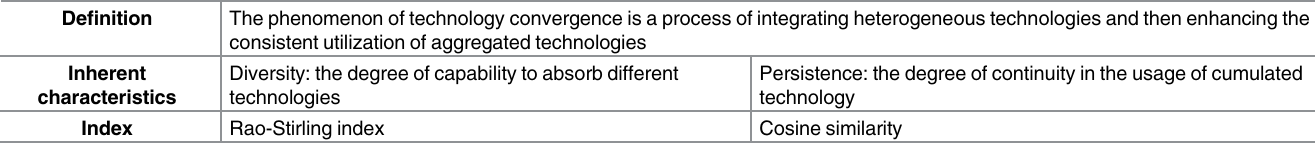
Table 3. Definition, Inherent Characteristics, and Methods of Technology